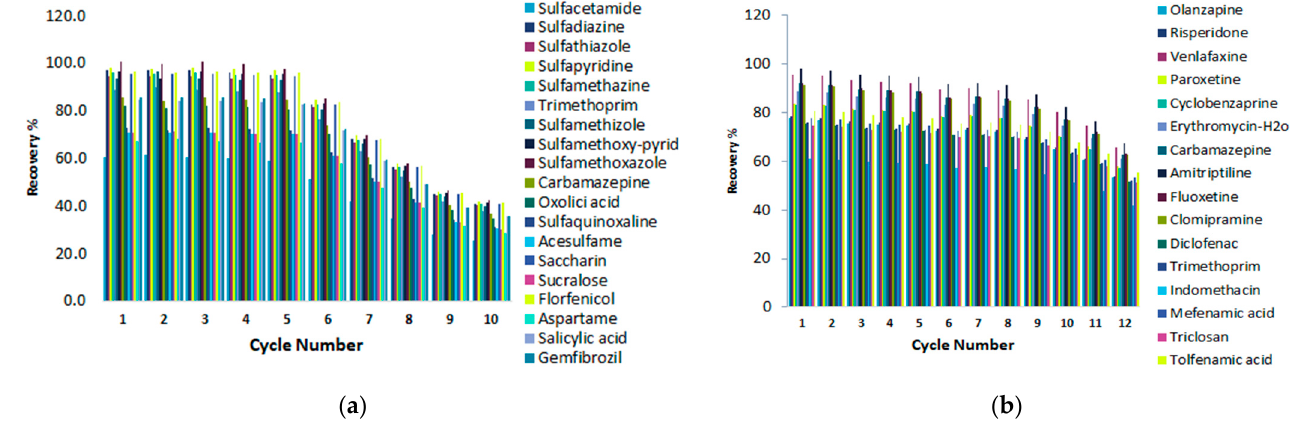
Figure 11. Reuse of the magnetic sorbents ( a ) Fe 3 O 4 @GO and ( b ) Fe 3 O 4 @SiO 2 @C18.